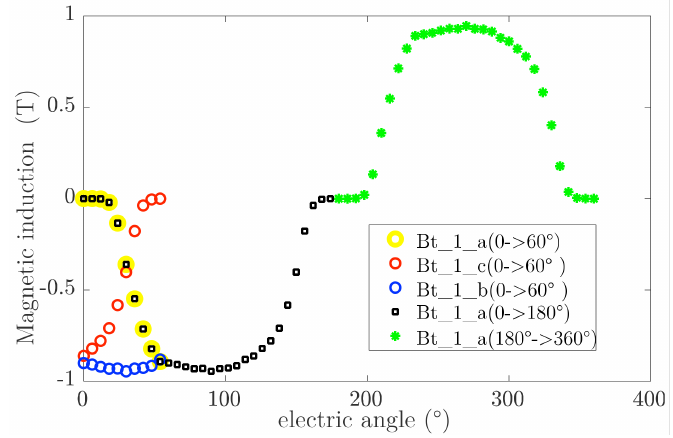
Figure 8. Tangential magnetic induction reconstruction into mesh element